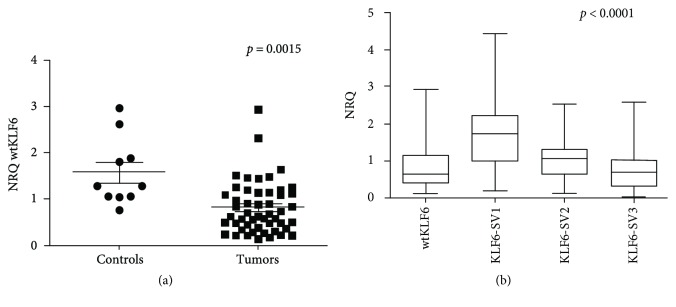
Expression of wtKLF6 in tumors compared to normal tissues. The normalized expression levels of the KLF6 wild-type isoform (a) in tumors versus normal tissues, and (b) the expression levels of the KLF6 wild-type isoform compared to those of the spliced variants KLF6-SV1, KLF6-SV2, and KLF6-SV3.